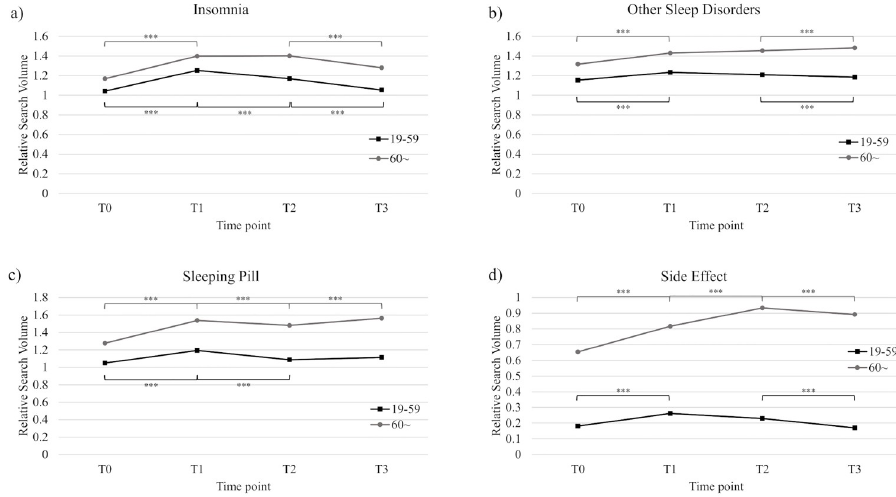
Fig 2. Log-transformed RSV data by age groups at time points T0 to T3. (a) Insomnia. (b) Other sleep disorders. (c) Sleeping pills. (d) Side effects.